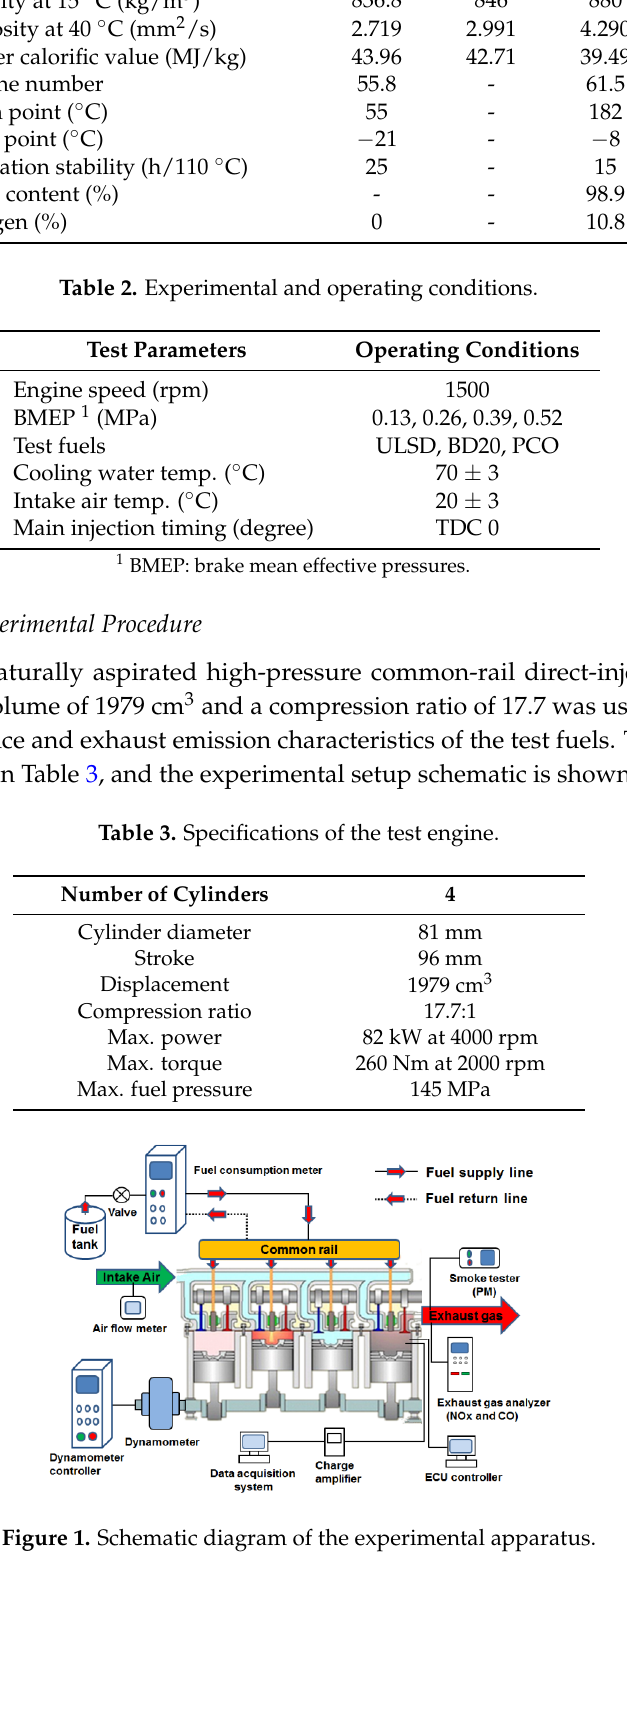
Table 1. Properties of ULSD (ultra low sulfur diesel), BD20 (20% canola oil blended with 80% ULSD by volume), and PCO (pure canola oil) fuels.